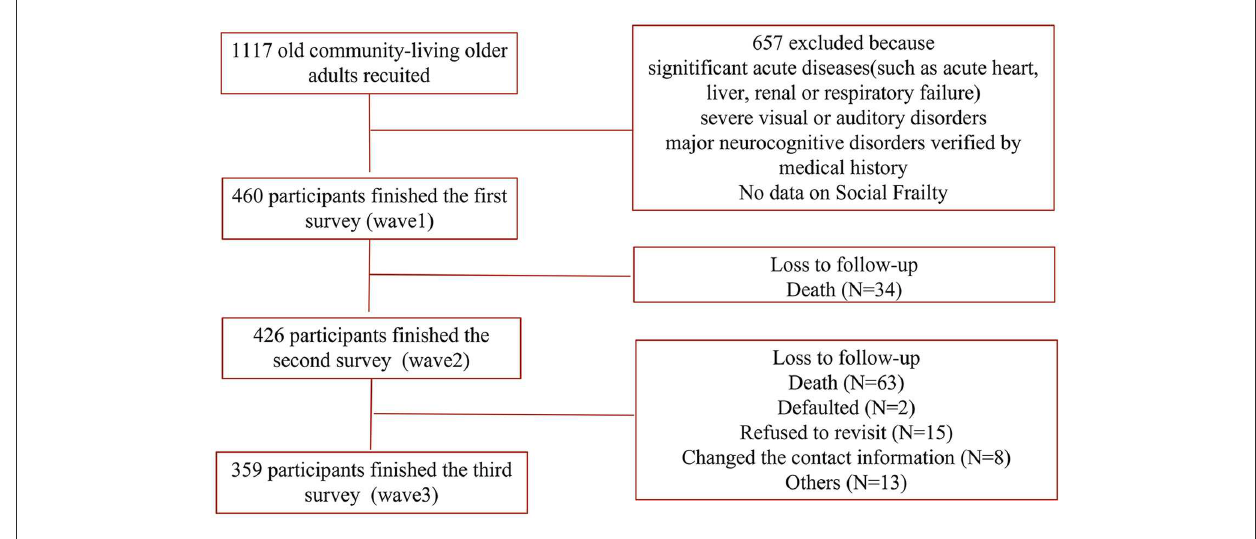
FIGURE1 Flow chart demonstrating the process used to select the study participants.